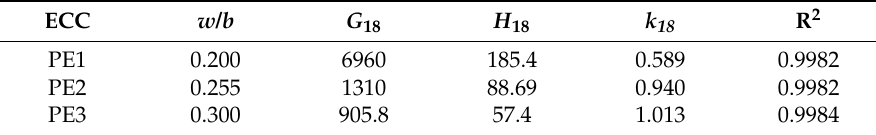
Table 11. Regression coefficients at f = 1.8 GHz and goodness of fits for Equation (6).